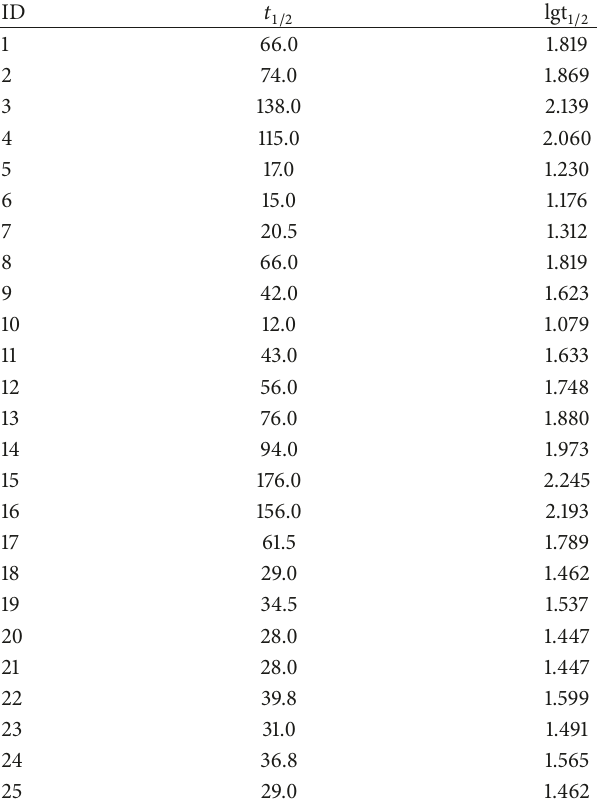
Table 2: Antimicrobial half-life ( 𝑡 1/2 ) (h) at the condition of mini- mum inhibition concentration of hydroxyl benzoic